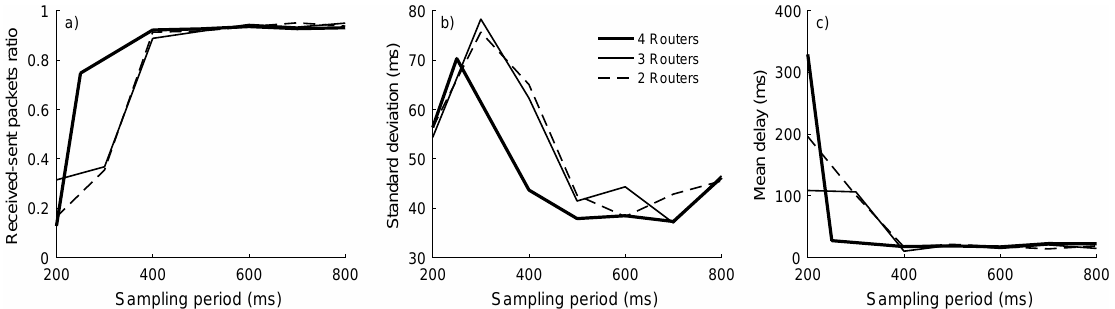
Figure 6. Network performance under different configurations: ( a ) Received-sent packets ratio, ( b ) Standard deviation and ( c ) Mean delay in the reception of